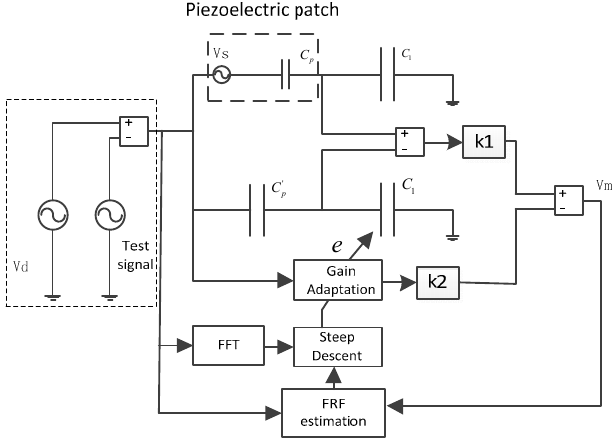
Figure 5. Schematic of the adaptive strategy for local strain.